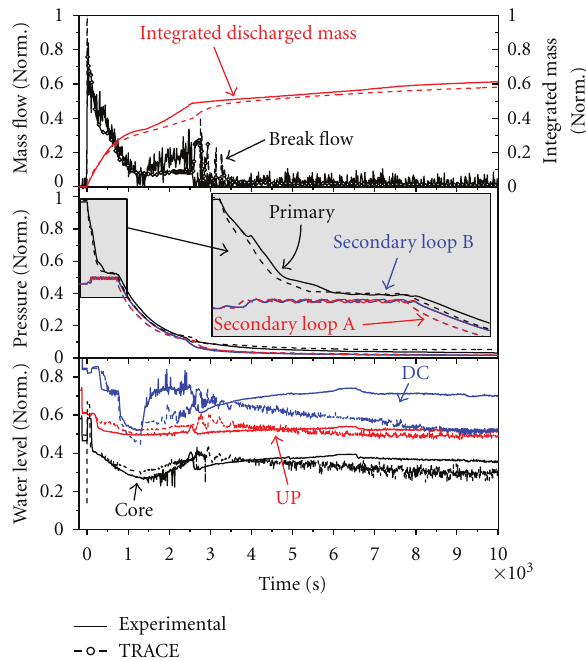
Figure 6: TRACE results for Test 5-2. From top to bottom: (1) break flow and integrated discharged mass, (2) primary and secondary pressures, and (3) RPV collapsed water levels.